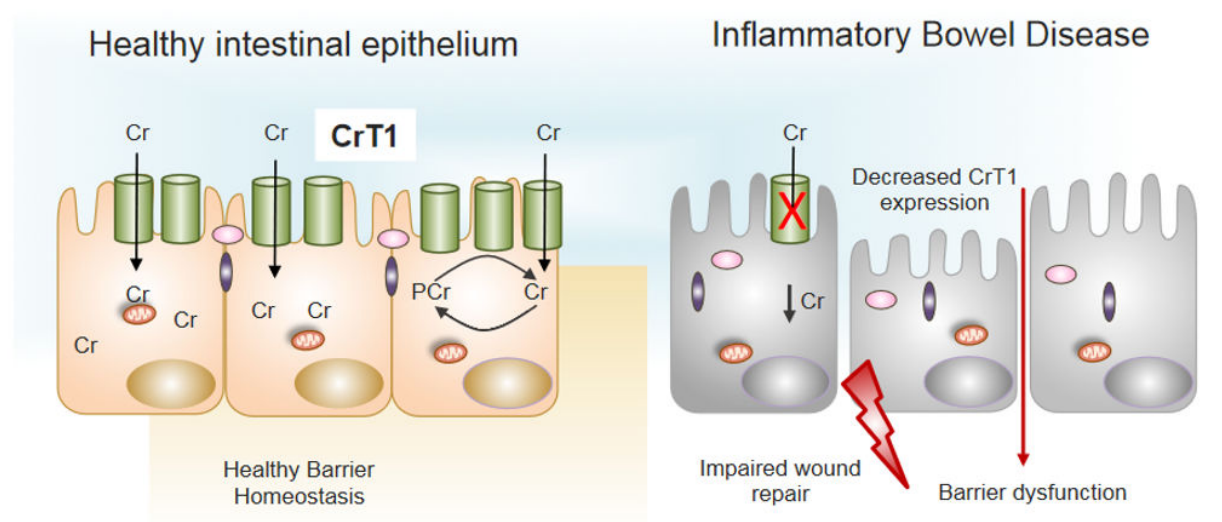
Figure 3. Decreased expression of CrT1 in IBD promotes barrier dysfunction. Normal expression of CrT1 on the apical surface of intestinal epithelia (left panel) results in adequate supplies of Cr via dietary sources to promote healthy barrier function and intestinal homeostasis. Patients with IBD express lower levels of CrT1 (right panel) and disrupt the Cr-PCr energy shuttle to the extent that wound healing potential and barrier are dysfunctional (see [14,16] for further